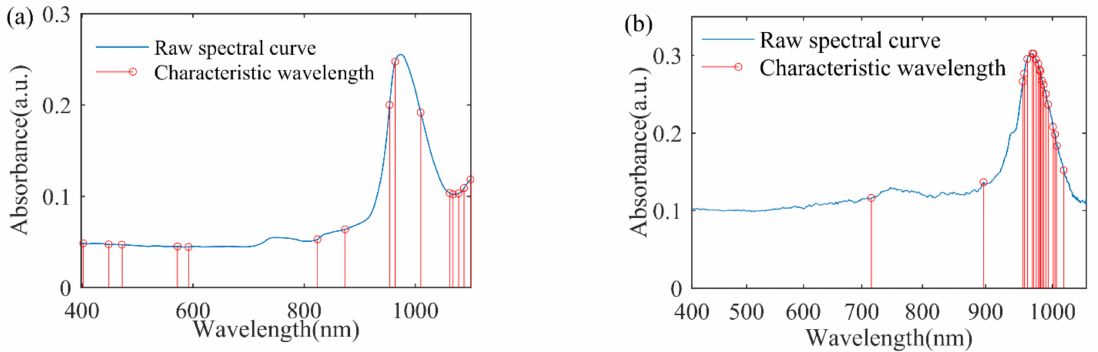
Figure 5. The distribution of wavelength variables selected by SPA: ( a ) spectrophotometer experiment; ( b ) grating spectrograph experiment.